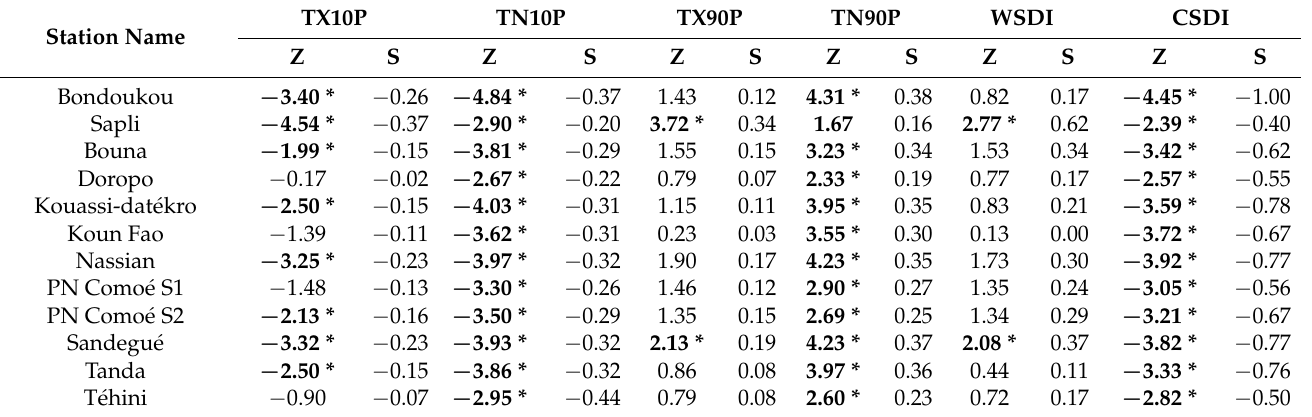
Table 5. Mann–Kendall (Z) trend test statistics and Sen’s slope (S) of extreme precipitation indices from 1981 to 2020 for the twelve